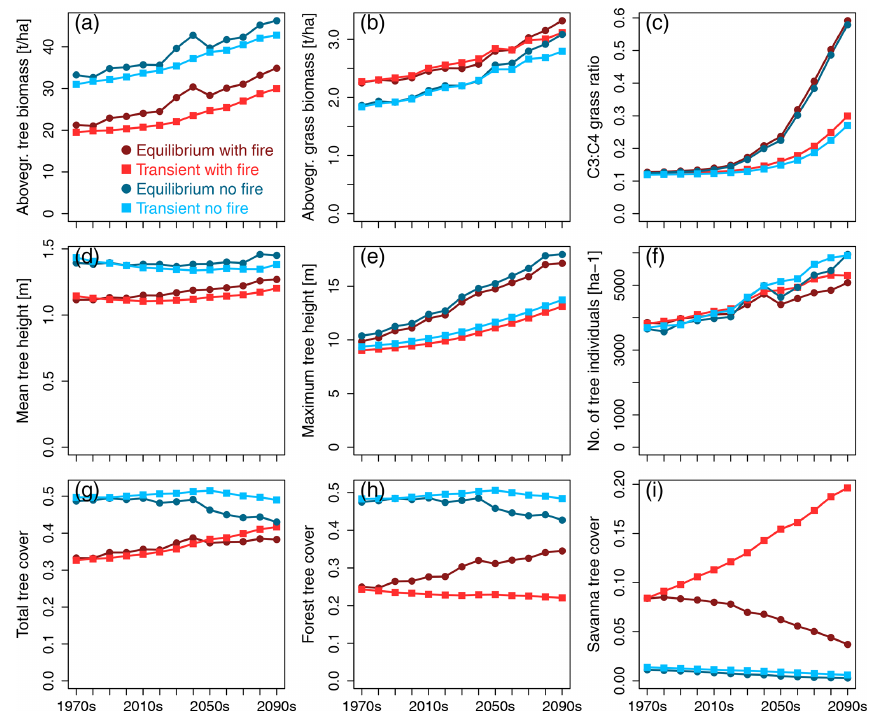
Figure 1. Time series of continental-scale spatial averages of variables for RCP8.5, calculated from decadal averages of grid